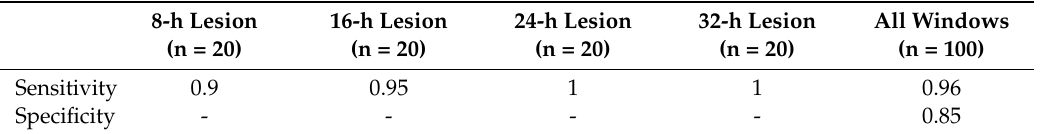
Table 5. Sensitivity and specificity analysis for NIR SFE measurements in the dry condition using 1460-nm light. A true positive represents a successful detection of demineralization and a true negative represents a successful detection of sound